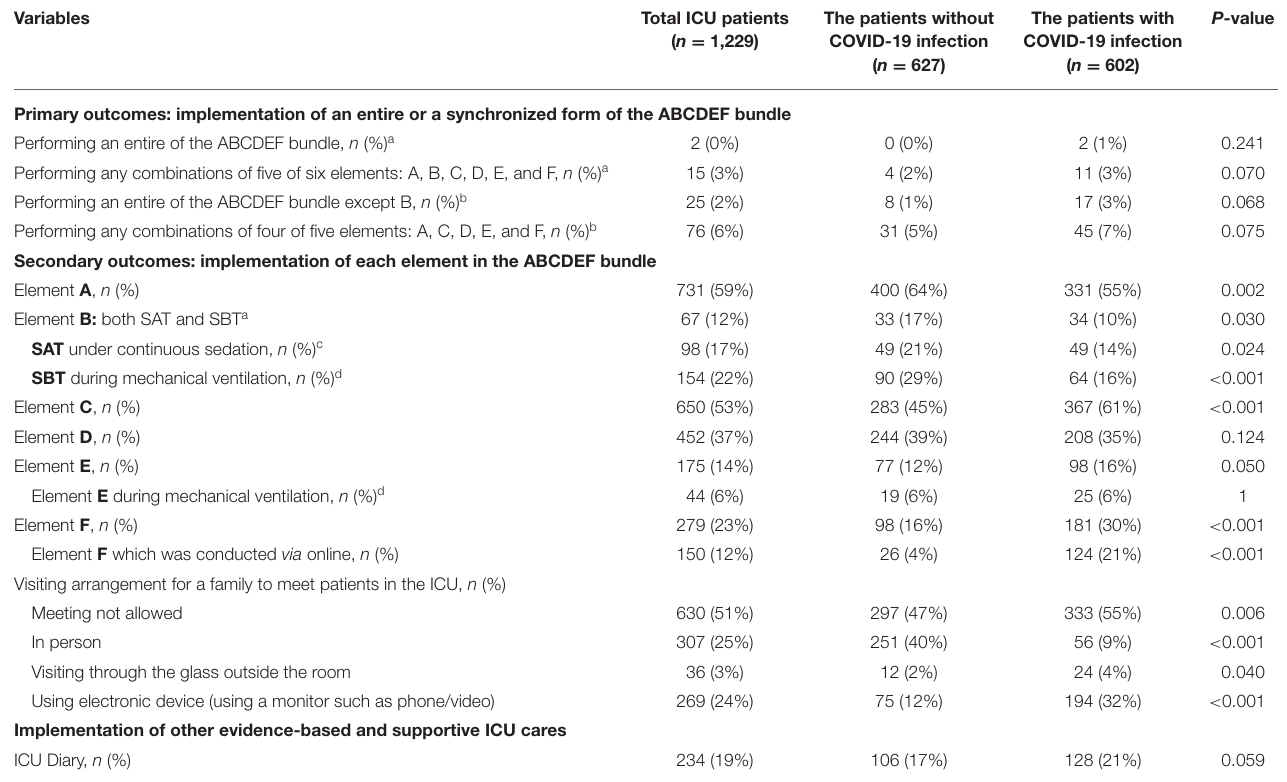
TABLE 4 | Comparison of implementation of evidence-based and supportive ICU care. Variables Total ICU patients